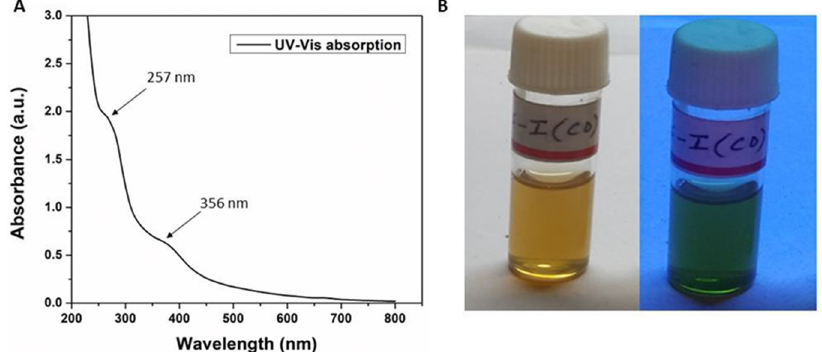
Figure 1. ( A ) UV–visible absorption spectrum of the prepared CDs. ( B ) CD solution in daylight (left) and under UV light (365 nm).